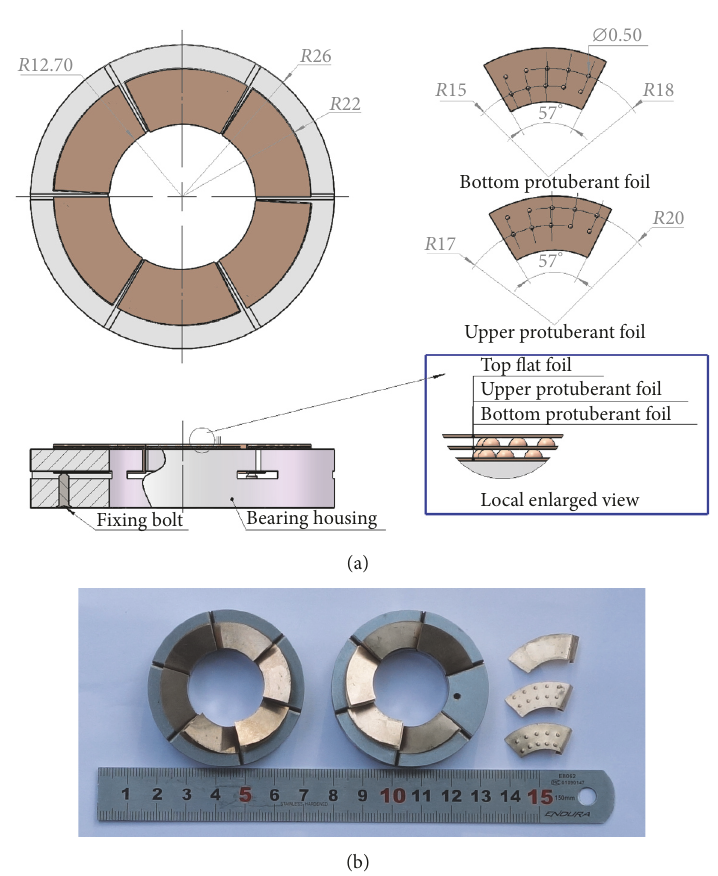
Figure 7: (a) Schematic diagram and (b) real picture of foil thrust bearing in the turboexpander.